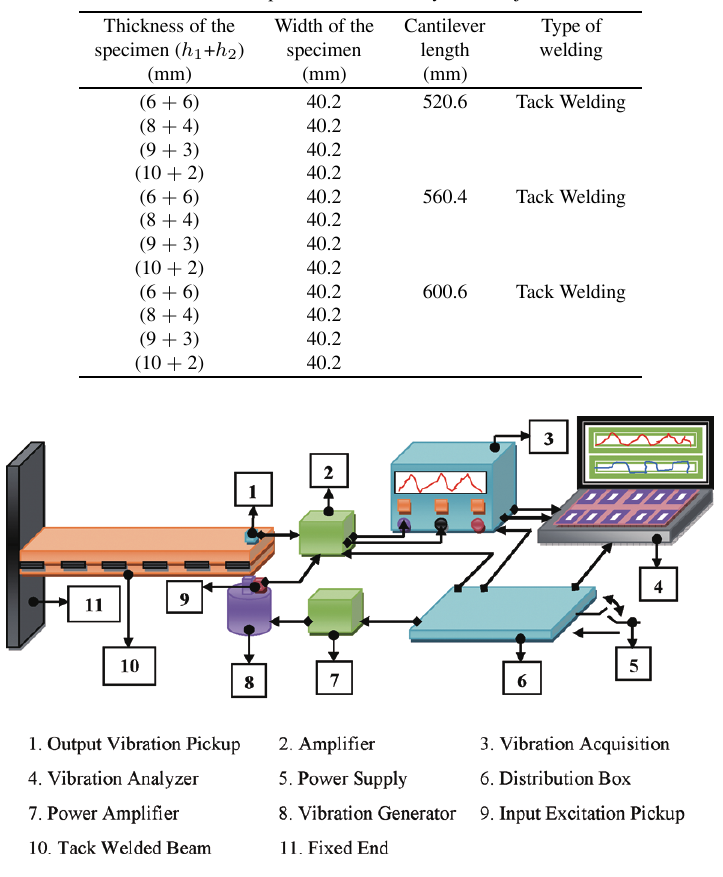
Fig. 2. Experimental